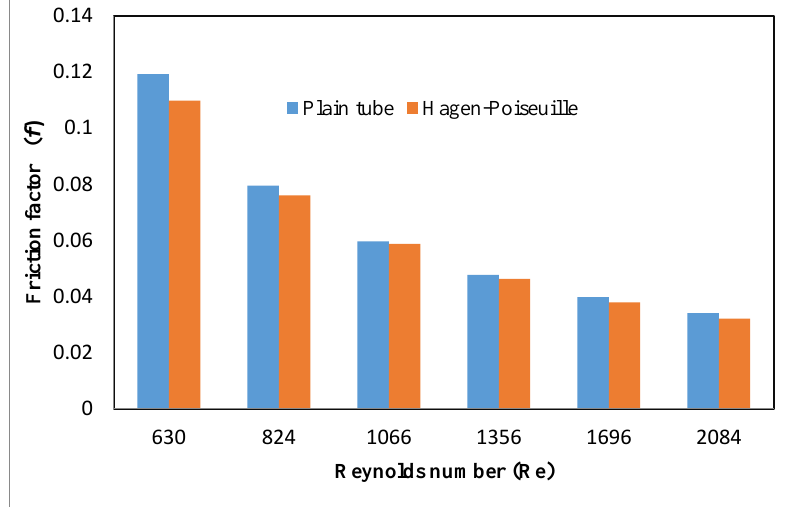
Figure 9. Validation of the experimental friction factor for a plain tube under laminar